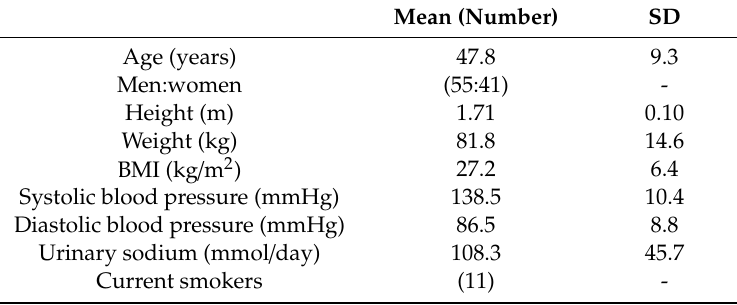
Table 1. Baseline characteristics of the group of adults with mildly to moderately elevated blood pressure ( n = 96) who participated in the reduced dietary salt intervention